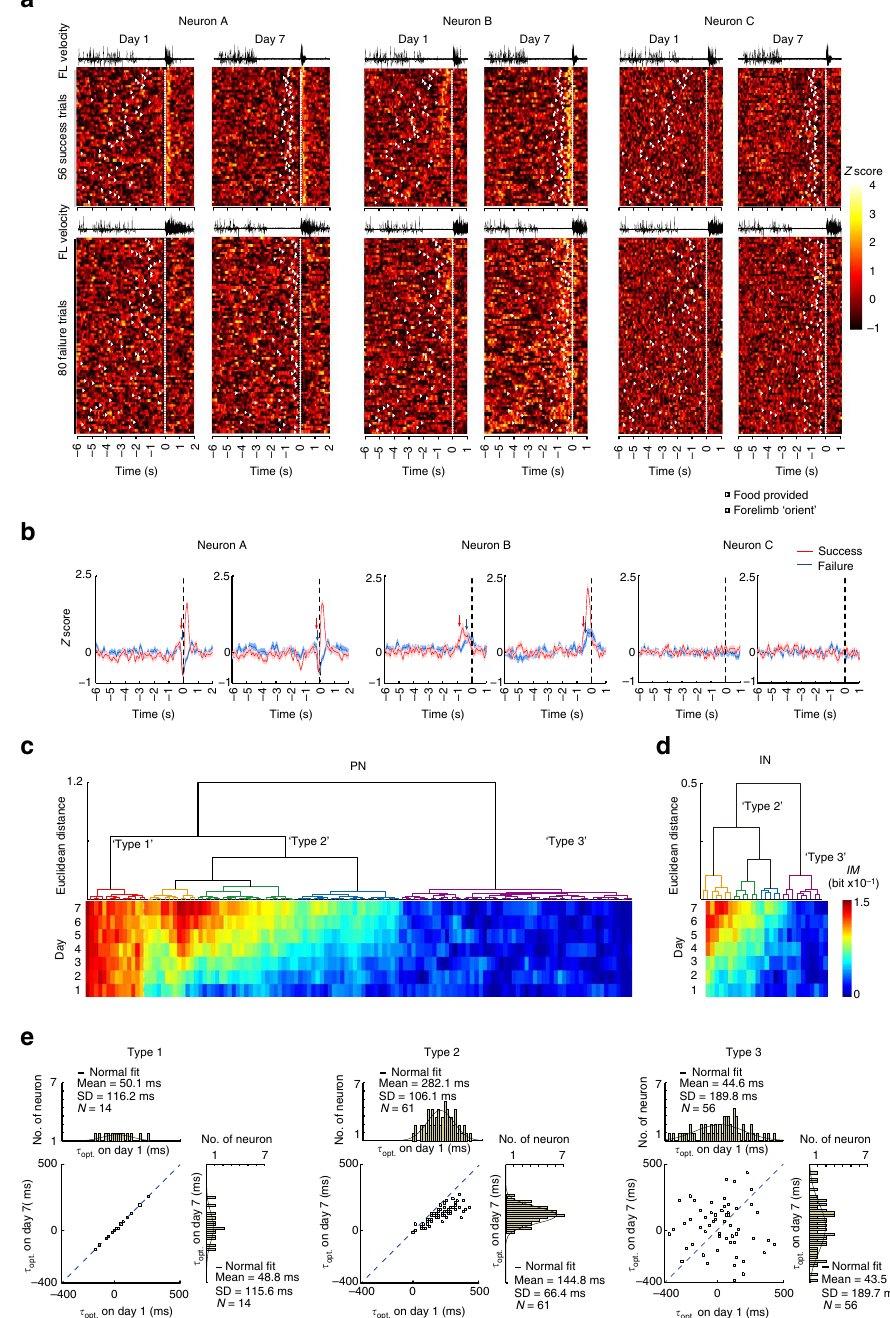
Figure 3 | Fine-temporal scale refinement of firing-motor output relationship in a subpopulation of L5b PNs. ( a ) Three examples of L5b PNs’ peri-event time histograms, aligned by the ‘orient’ position (time ‘0’, white dots). Fifty-six consecutive first reach success and 80 consecutive first reach failure trials are stacked. White arrows indicate the time when food pellets were provided. The correspondent forelimb velocity, are shown overlaid on the top. Neural activities were normalized and expressed as Z score. Neuron A’s firing highly correlated with forelimb action but remained unchanged with training. Neuron B’s firing became correlated with forelimb action after training. Neuron C’s firing did not correlate with forelimb reaching action irrespective of training. ( b ) Averaged neural activities of the three L5b PNs shown in a during first reach success (red, mean ± s.e.m.) and first reach failure (blue, mean ± s.e.m.) trials on days 1 and 7. Arrows indicate the time when the neural activity began to diverge (TUD, time until divergence, see Methods). ( c ) Hierarchical clustering of 131 L5b PNs (recorded from five rats) based on single neuron I M during motor learning. The dendrogram (upper half) depicts Euclidean distance of single PN I M vectors across 7 training days, with major subgroups indicated by different colours in the dendrogram. ( d ) Twenty-seven L5b INs (recorded from five rats) were classified into subgroups by applying the same method of hierarchical clustering of single neuron I M as shown in c . ( e ) Summary of training-dependent changes of the optimal time lag of I M ( t opt. for the three major types of L5b PNs (recorded from five rats) classified by hierarchical clustering. Frequency histograms of individual neuron t opt. at days 1 and 7 are shown on the top and the right respectively. Sixty out of sixty-one of type 2 neurons exhibit a decrease in t opt. , which are distributed below the dashed line with unit slope.